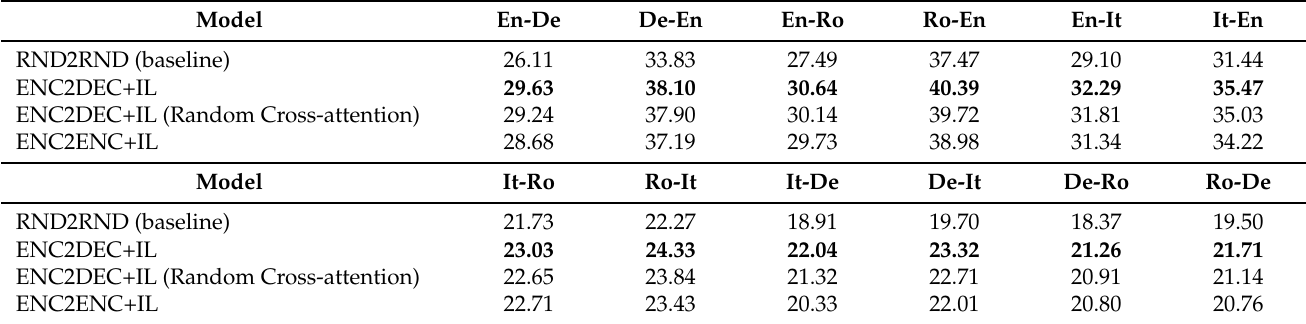
Table 4. Fine-tuning models with different decoder initialization. The Baseline is a randomly initialized Transformer and IL is the intermediate layer. We indicate the best scores with bold font.